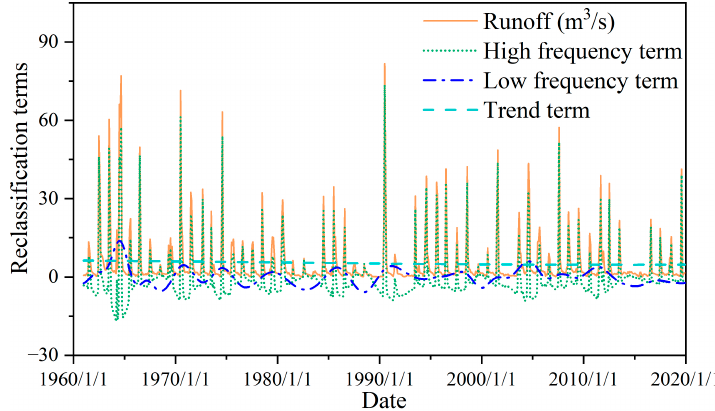
Figure 18. The reclassified IMF terms and original runoff data for Laiwu station.